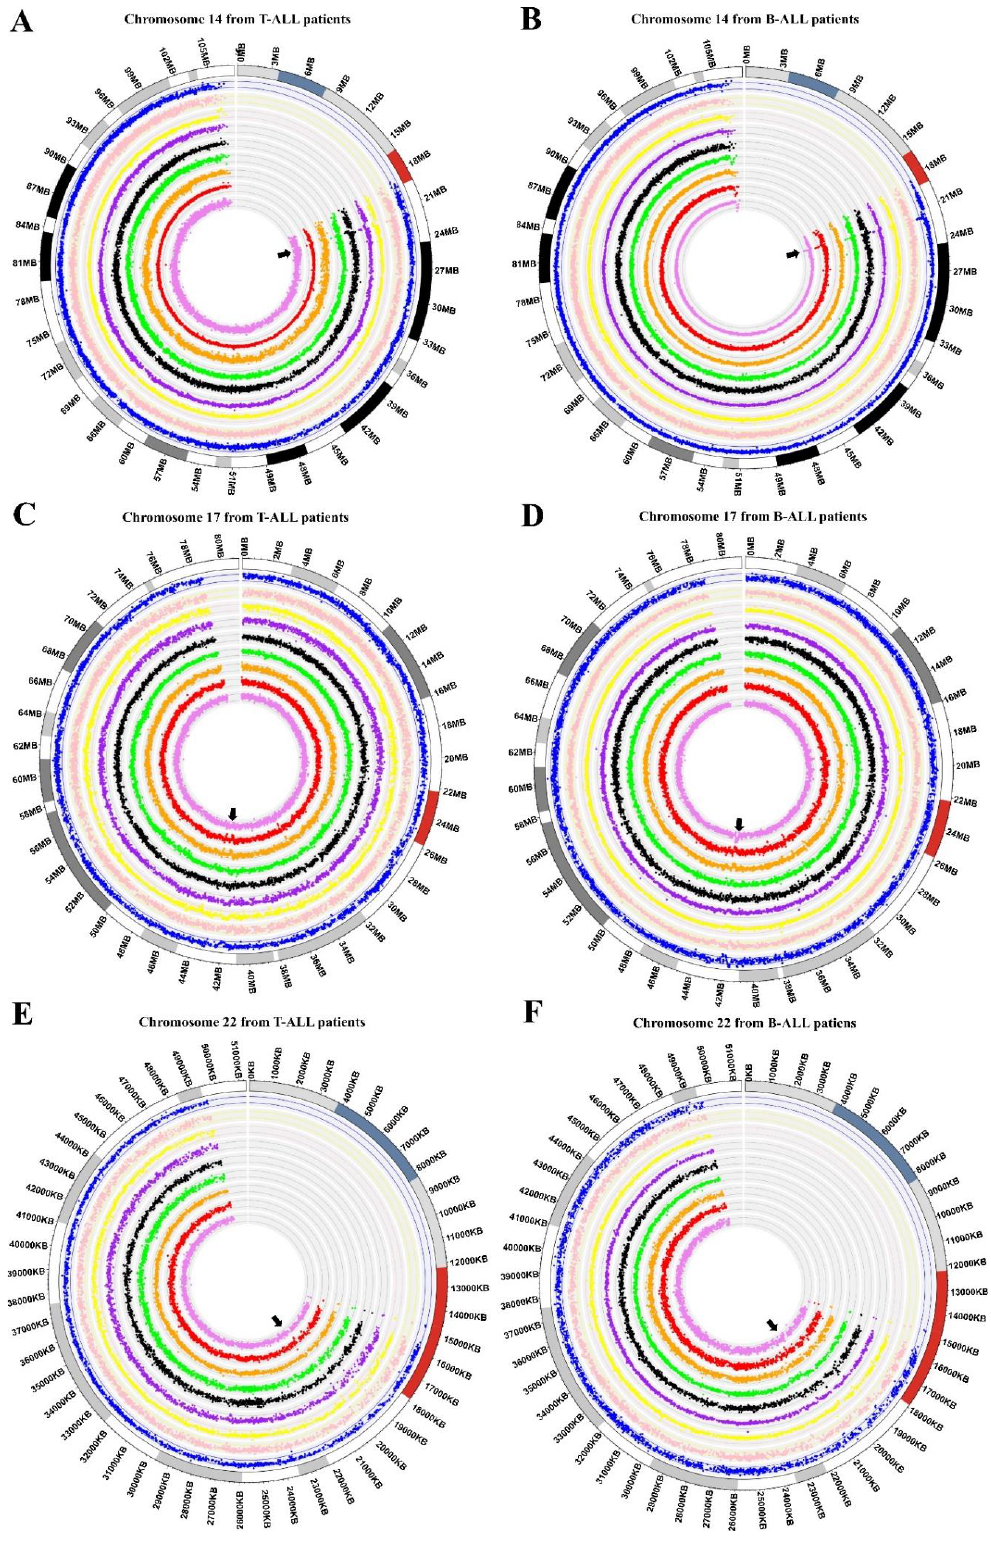
Figure 4. Circular multitrack plot representation of genomic data. The circos plots show ideograms of Log2-normalized genomic data from chromosome 14 ( A , B ), chromosome 17 ( C , D ), and chromosome 22 ( E , F ). Each level of the diagram represents a patient, and common zones of gain are highlighted with black arrows. As appropriate, the chromosome size scale is shown in megabases (Mb) or kilobases (Kb); ( A , C , E ) represent data from T-ALL; ( B , D , F ) represent data from